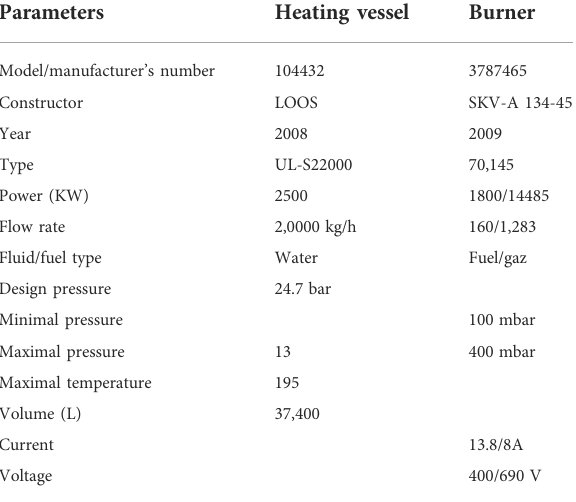
TABLE 1 Boiler and burner